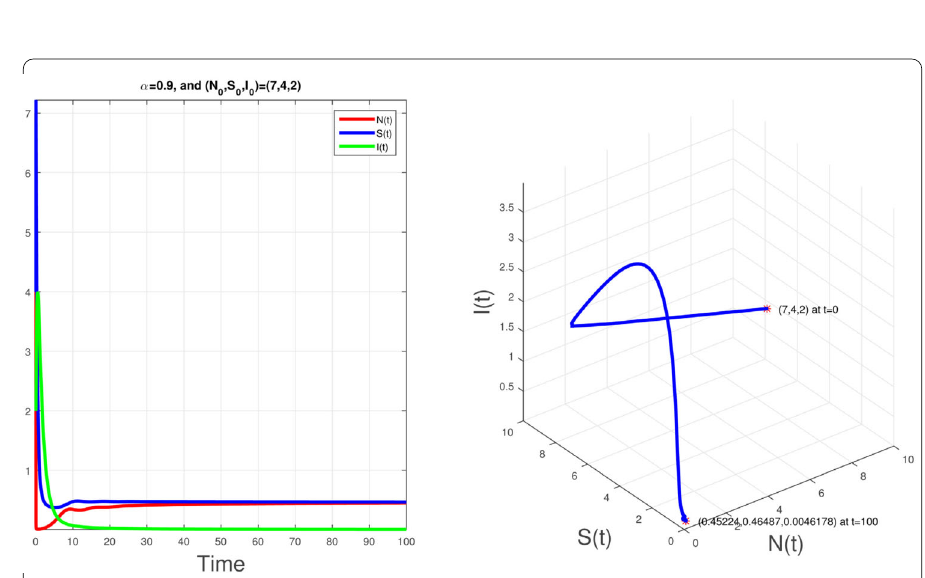
Figure 3 Extinction of the infection which is elaborated by the stability of the DFE